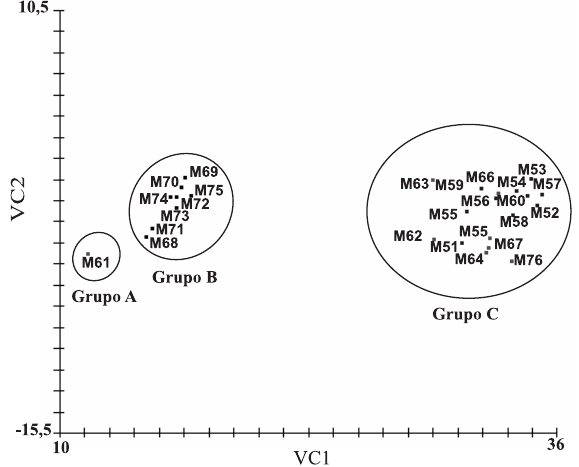
Figura 3. Dispersão gráfica em relação às duas primeiras variáveis canônicas (VC1 e VC2), calculadas a partir das características morfométricas, mostrando a relação dos 26 fungos isolados das quatro populações de Epidendrum secundum. População I, isolados M51 a M60, população II, isolados M61 a M67, população III, isolados M68 a M76, e população IV, isolado M76.